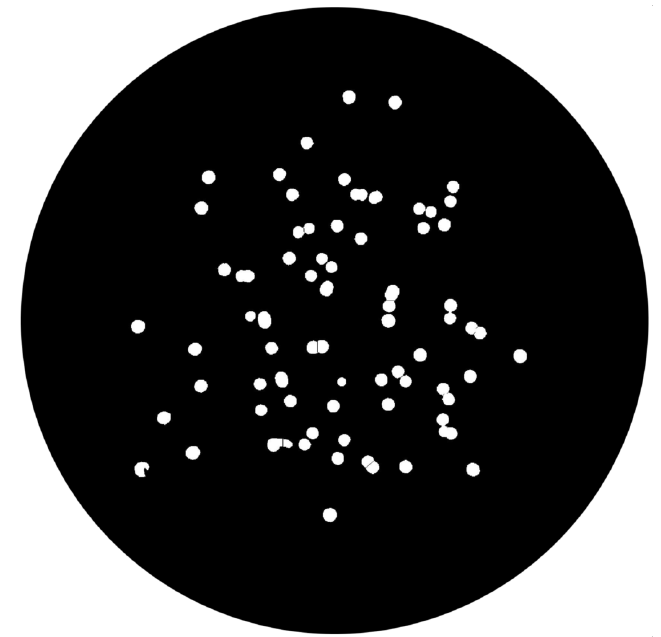
Figure 18. Area filtered image.